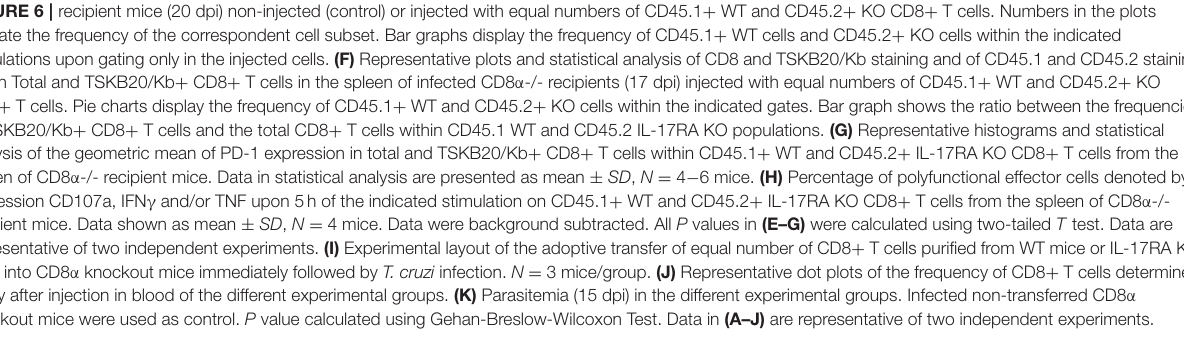
FIGURE 6 | recipient mice (20 dpi) non-injected (control) or injected with equal numbers of CD45.1 + WT and CD45.2 + KO CD8 + T cells. Numbers in the plots indicate the frequency of the correspondent cell subset. Bar graphs display the frequency of CD45.1 + WT cells and CD45.2 + KO cells within the indicated populations upon gating only in the injected cells. (F) Representative plots and statistical analysis of CD8 and TSKB20/Kb staining and of CD45.1 and CD45.2 staining within Total and TSKB20/Kb + CD8 + T cells in the spleen of infected CD8 α -/- recipients (17 dpi) injected with equal numbers of CD45.1 + WT and CD45.2 + KO CD8 + T cells. Pie charts display the frequency of CD45.1 + WT and CD45.2 + KO cells within the indicated gates. Bar graph shows the ratio between the frequencies of TSKB20/Kb + CD8 + T cells and the total CD8 + T cells within CD45.1 WT and CD45.2 IL-17RA KO populations. (G) Representative histograms and statistical analysis of the geometric mean of PD-1 expression in total and TSKB20/Kb + CD8 + T cells within CD45.1 + WT and CD45.2 + IL-17RA KO CD8 + T cells from the spleen of CD8 α -/- recipient mice. Data in statistical analysis are presented as mean ± SD , N = 4 − 6 mice. (H) Percentage of polyfunctional effector cells denoted by expression CD107a, IFN γ and/or TNF upon 5h of the indicated stimulation on CD45.1 + WT and CD45.2 + IL-17RA KO CD8 + T cells from the spleen of CD8 α -/- recipient mice. Data shown as mean ± SD , N = 4 mice. Data were background subtracted. All P values in (E–G) were calculated using two-tailed T test. Data are representative of two independent experiments. (I) Experimental layout of the adoptive transfer of equal number of CD8 + T cells purified from WT mice or IL-17RA KO mice into CD8 α knockout mice immediately followed by T. cruzi infection. N = 3 mice/group. (J) Representative dot plots of the frequency of CD8 + T cells determined 1 day after injection in blood of the different experimental groups. (K) Parasitemia (15 dpi) in the different experimental groups. Infected non-transferred CD8 α knockout mice were used as control. P value calculated using Gehan-Breslow-Wilcoxon Test. Data in (A–J) are representative of two independent